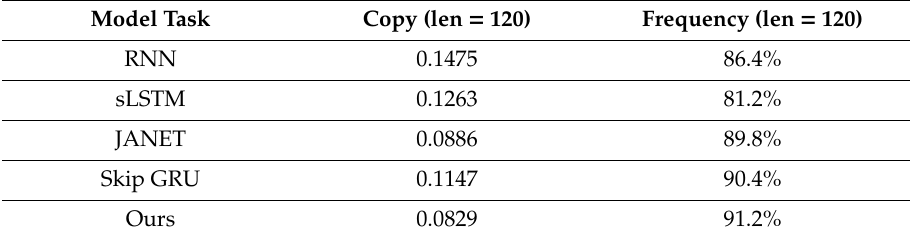
Table 2. Experimental results of the copy and frequency discrimination